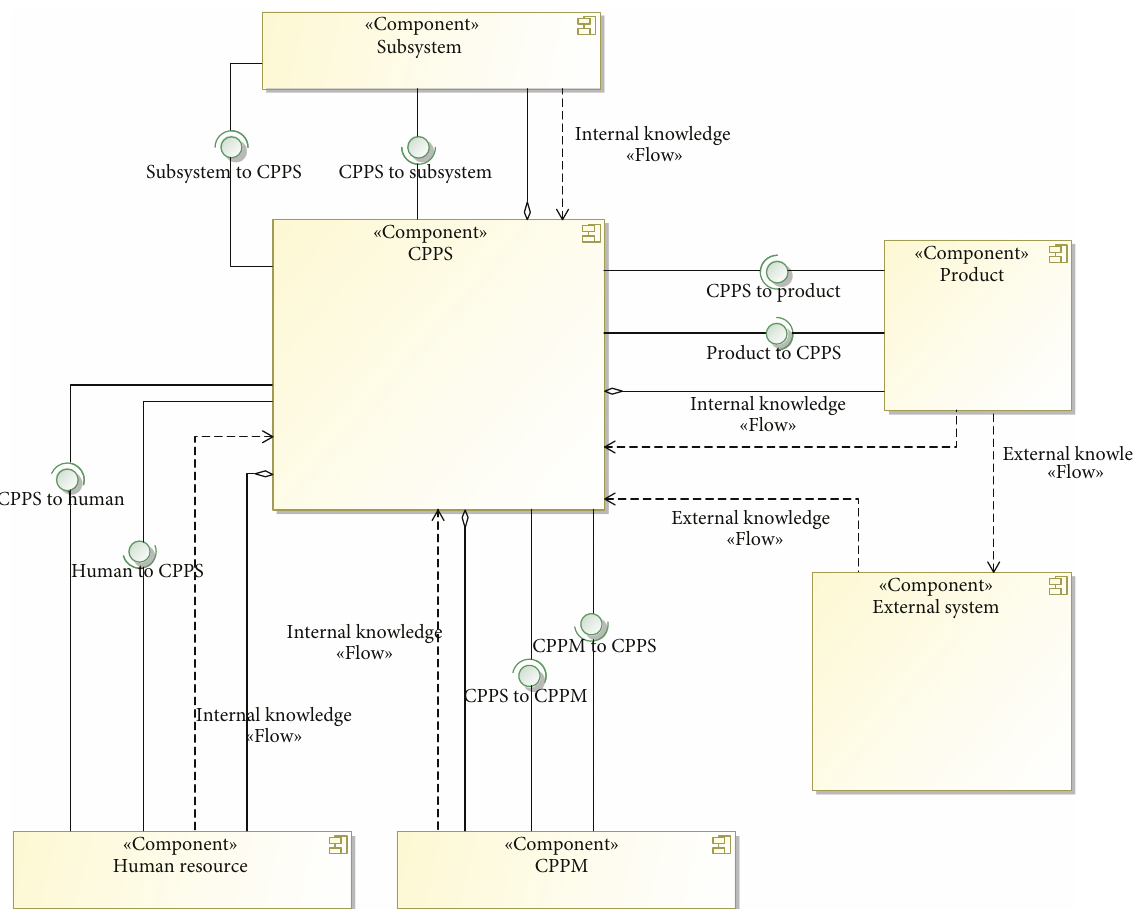
Figure 1: CPPS structural model (adapted from